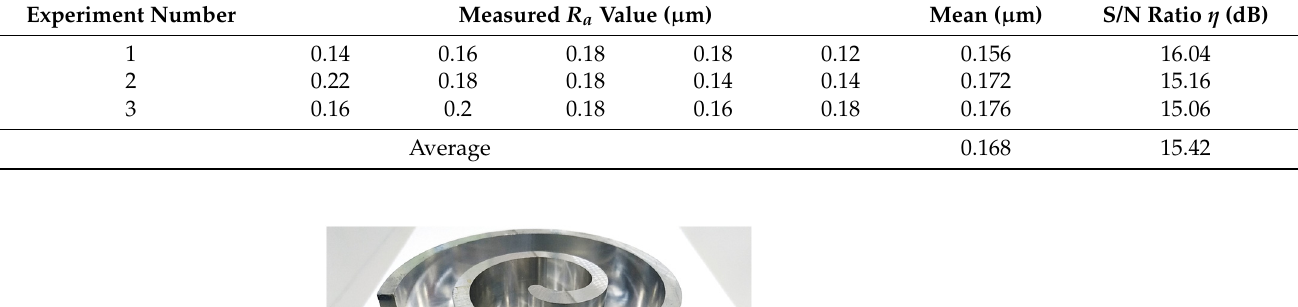
Table 18. Mean values and S/N ratios for surface roughness from verification experiments.